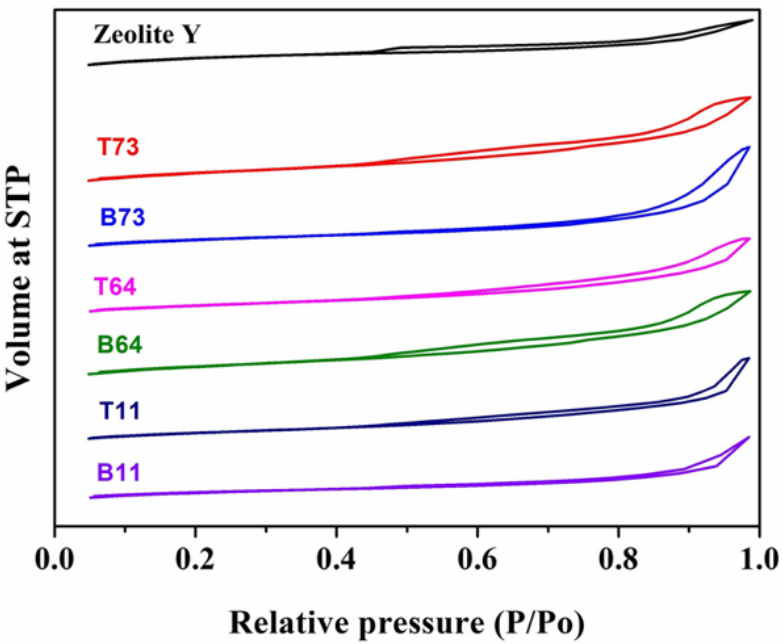
Figure 11. Adsorption-desorption isotherms of nitrogen for parent zeolite Y and ball-milled sample.